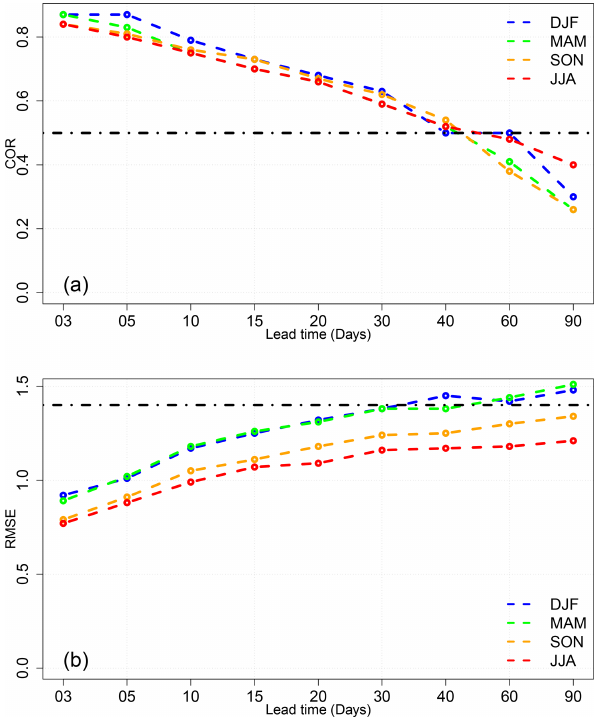
Figure 10. The COR (a) and RMSE (b) for the different lead times of forecasts from 3 to 90d over the period from 1979 to 2020 for the different seasons DJF, JJA, MAM, and